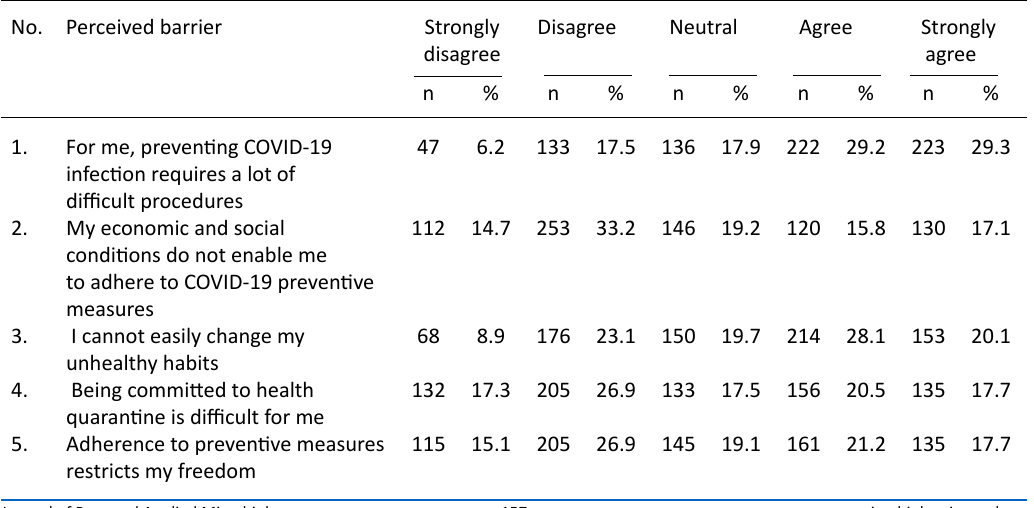
table 1. Percentage distribution of the study participants according to their perceived barrier scores (n=761) No. Perceived